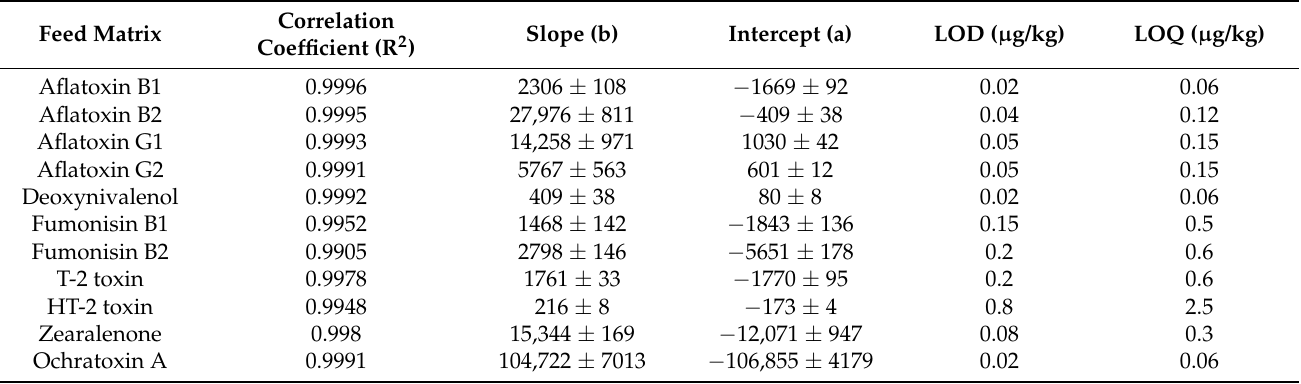
Table 4. Linear equations and regression coefficients of the matrix-matched standard calibration curves ( n = 3).